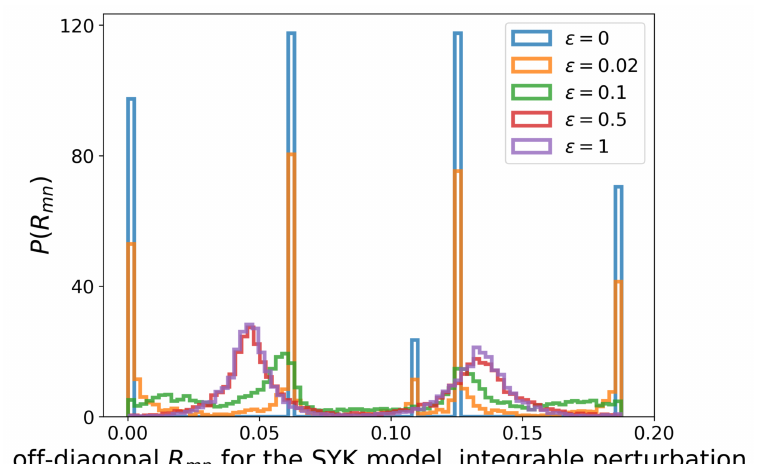
Figure 22 . The distribution of off-diagonal R mn for the SYK model with an integrable perturba- tion (6.7). The number of Majorana fermions is 14 and the degree of locality is k = 4